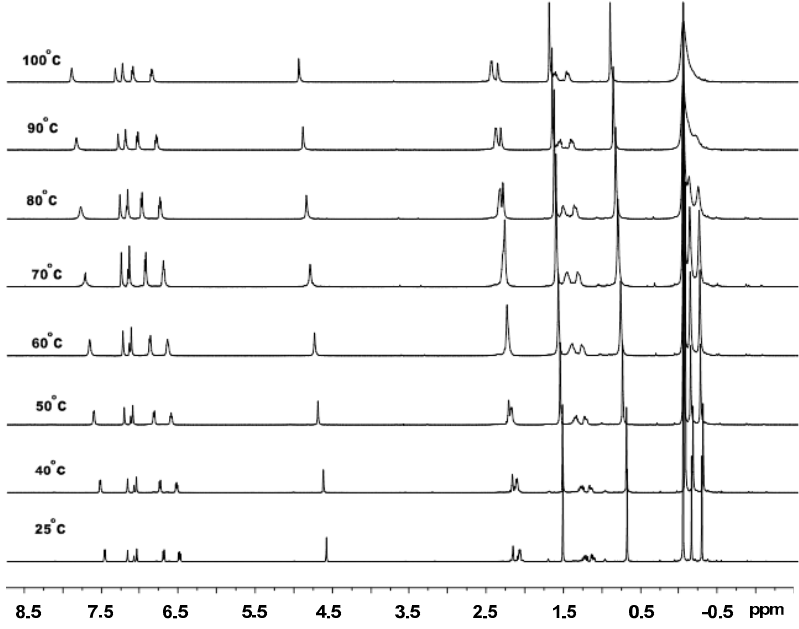
Figure 7. VT- 1 H NMR spectra of C1 recorded between 25 and 100 °C (in toluene- d 8 ).